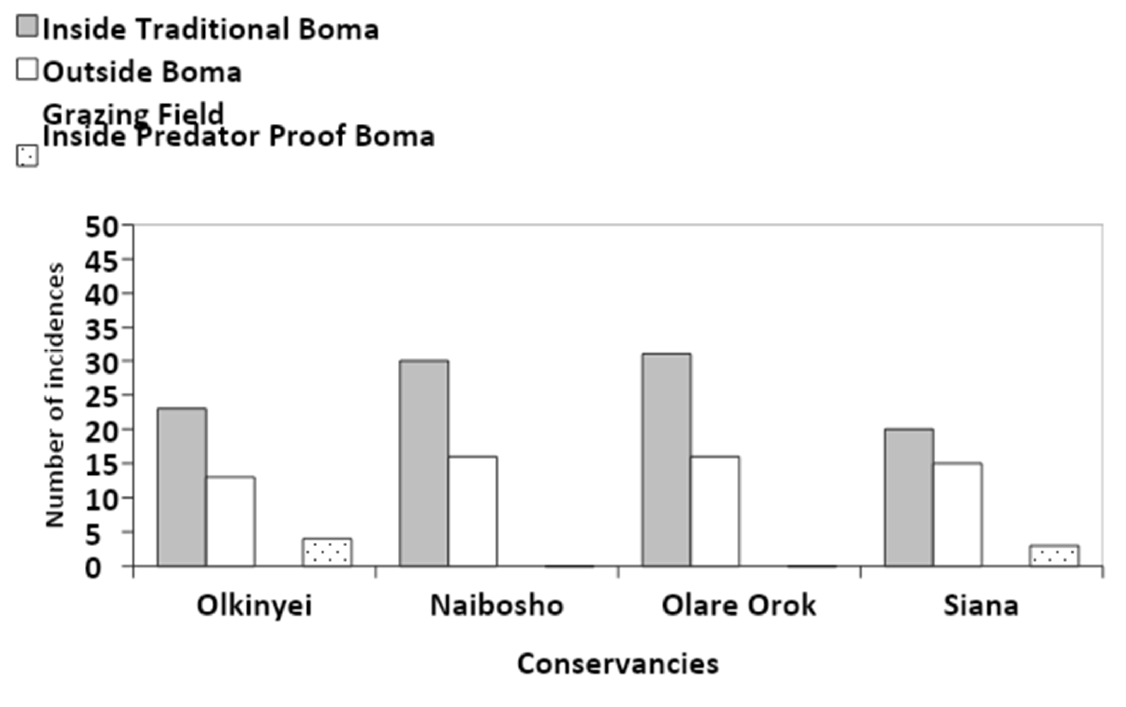
Figure 4. Distribution of livestock depredation in conservancies. Table 2. Distribution of livestock depredation incidences in relation to the location of attack and livestock species predated